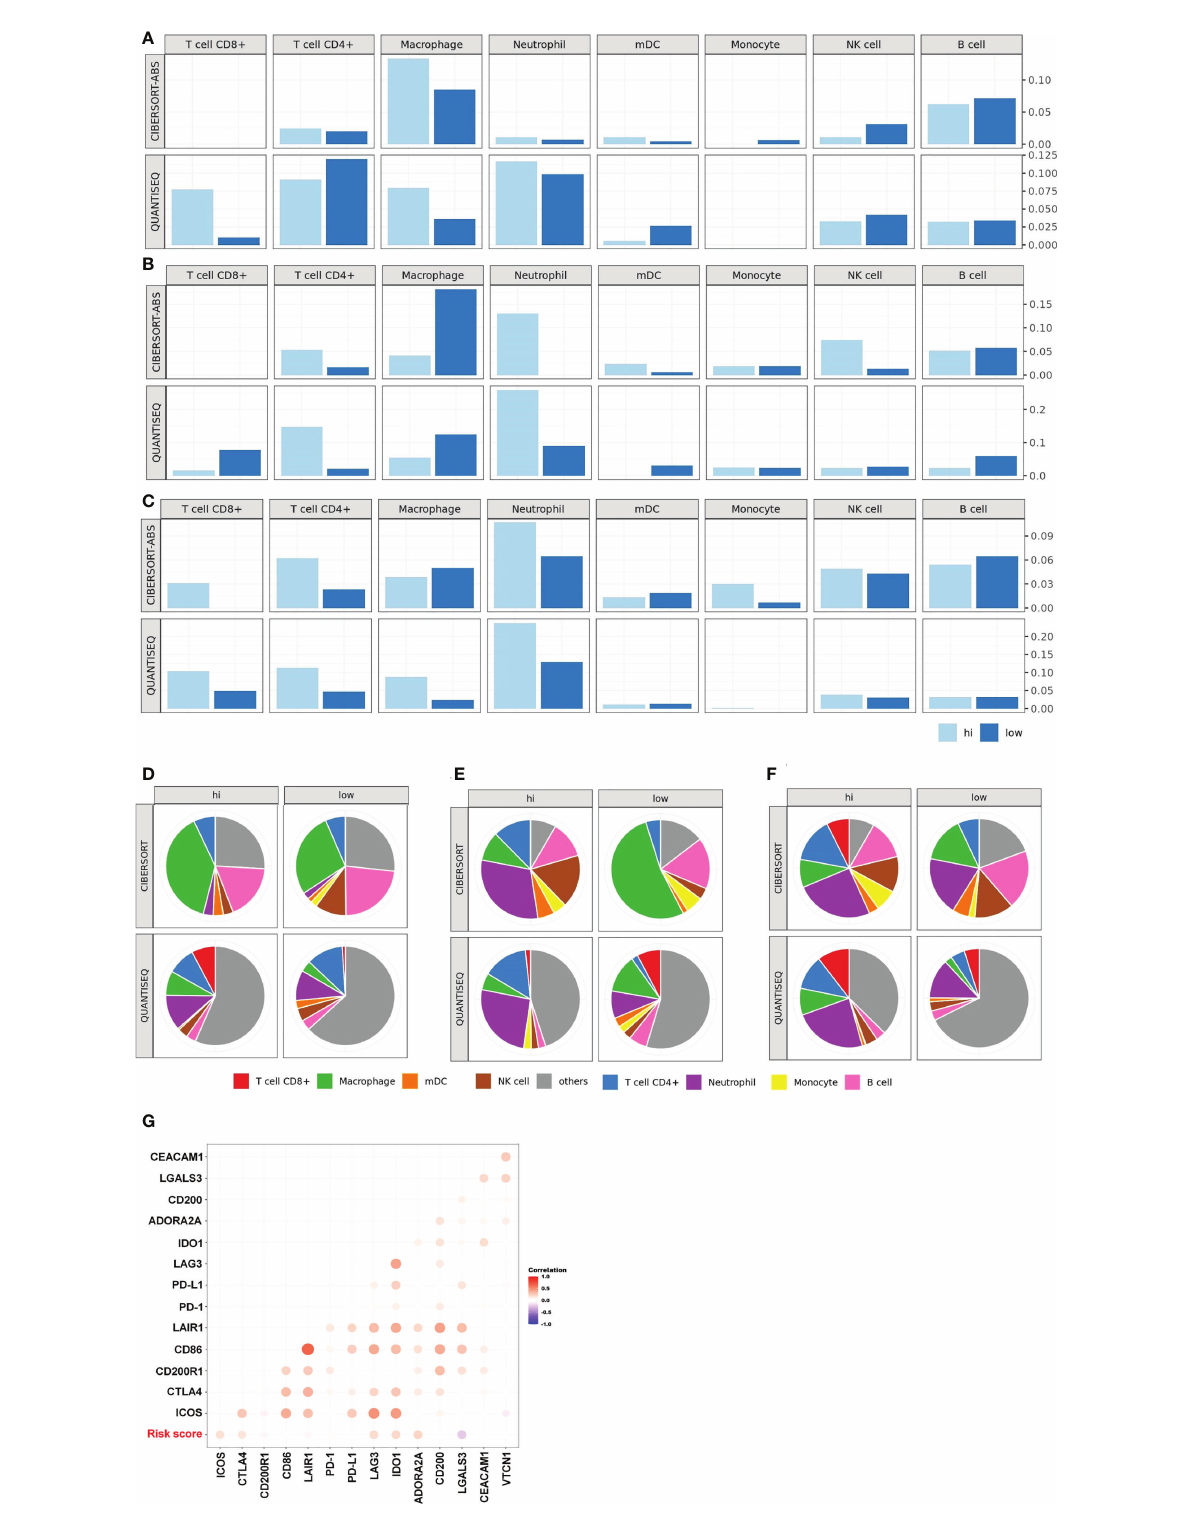
FIGURE 5 Characteristics of tumor microenvironment in high-risk patients. TIL levels of the high- and low-risk groups in luminal BC (A) , HER2+ BC (B) , TNBC (C) . Proportion of immune cells of the high- and low-risk groups in luminal BC (D) , HER2+ BC (E) , TNBC (F) . (G) Heat map of the correlation between risk score and the expression of multiple immunosuppressive regulatory molecules based on the whole